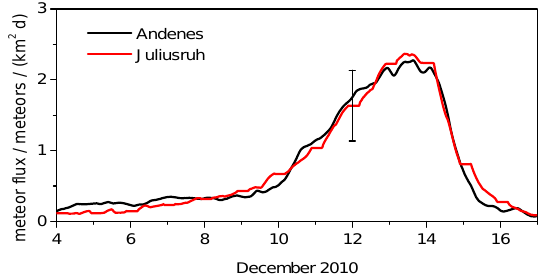
Fig. 10. Comparison of absolute fluxes for the Andenes and Julius- ruh MR after the subtraction of the baseline due to sporadic background activity close to the Geminid source radiant. The x- tickmarks indicate 00:00UTC for each